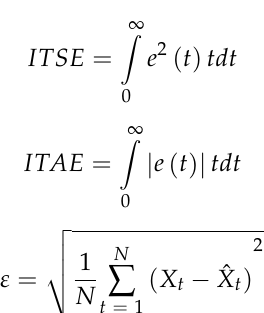
Table 4. Configuration parameters of the BCO algorithm. Parameter Values Population 50 Employed Bee 30 Iterations Alpha Beta Dynamic